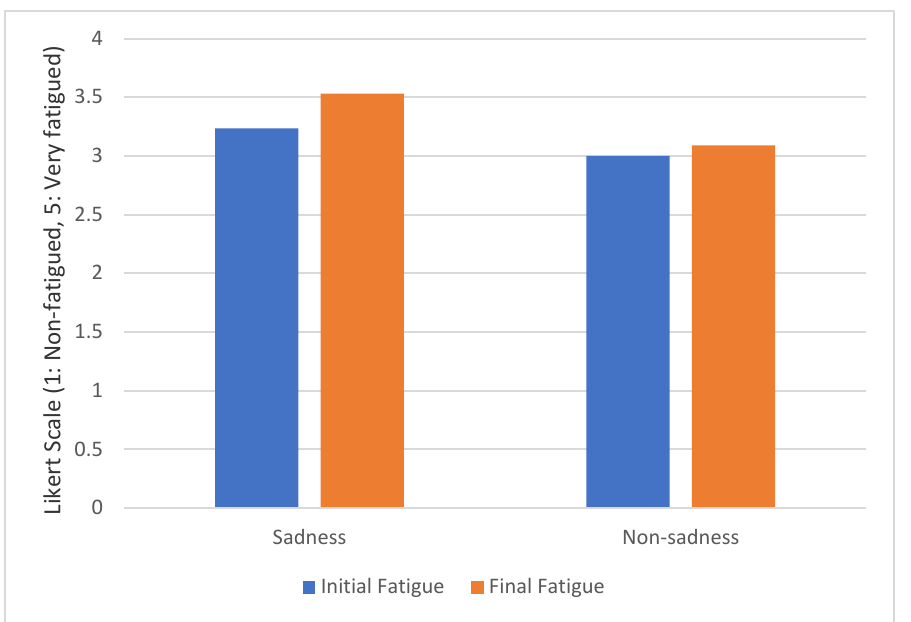
Figure 5. Fatigue evolution grouped by sadness level.